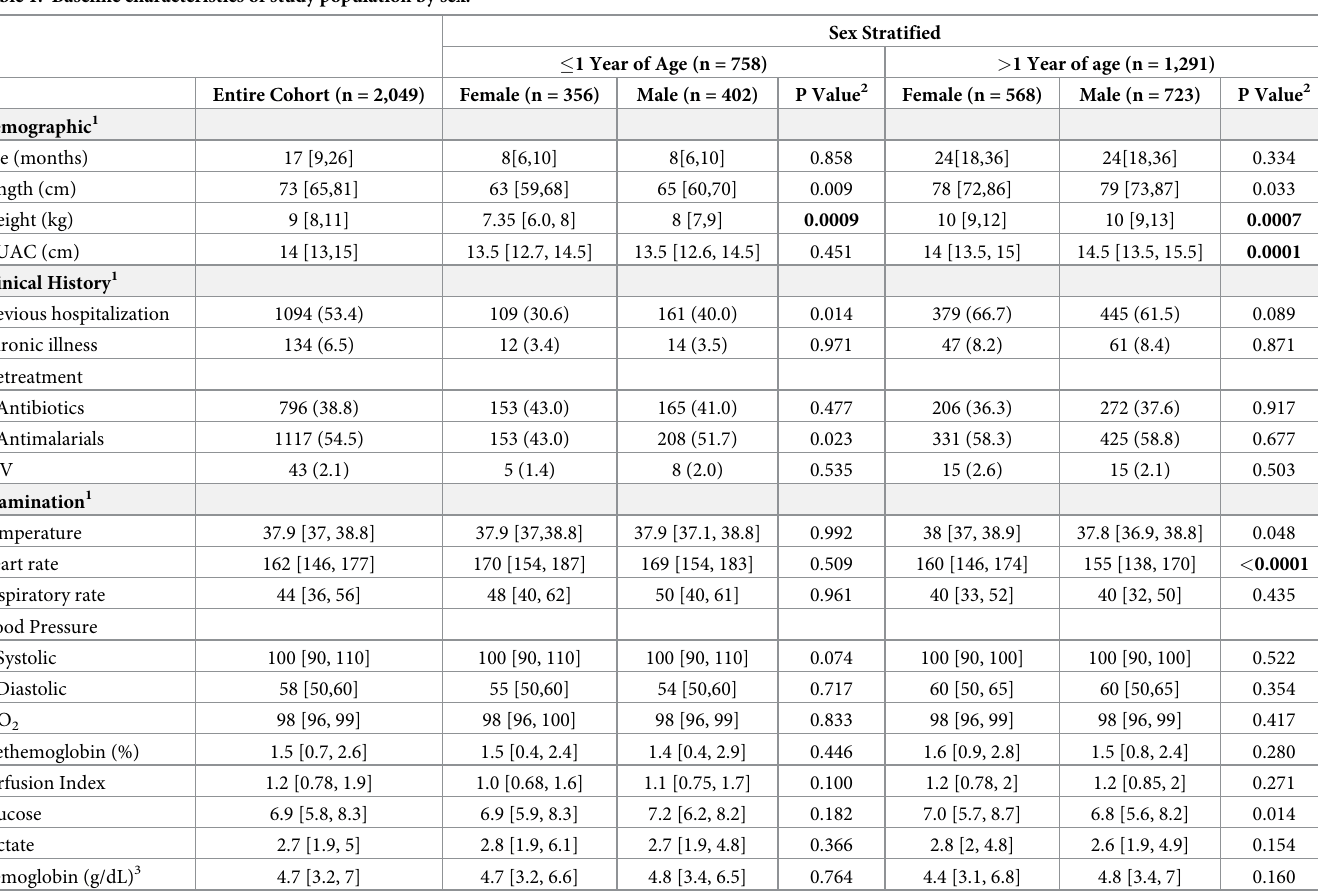
Table 1. Baseline characteristics of study population by